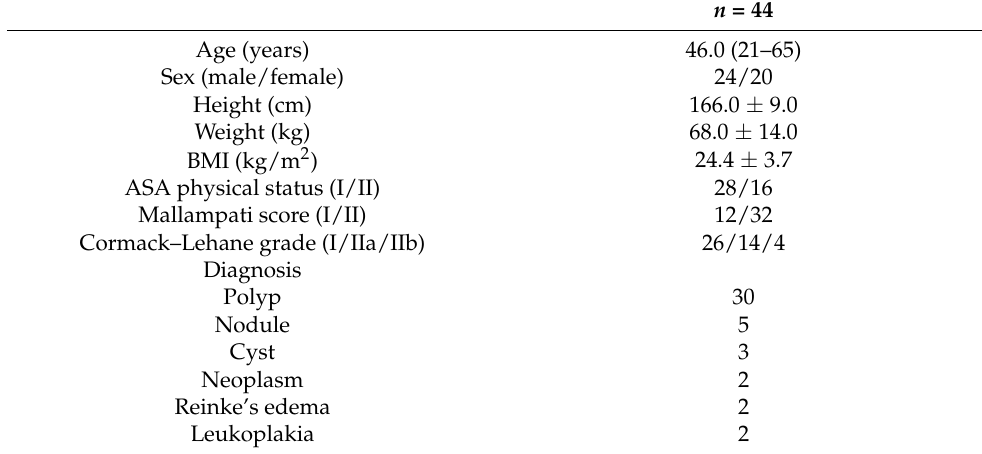
Table 1. Patients’